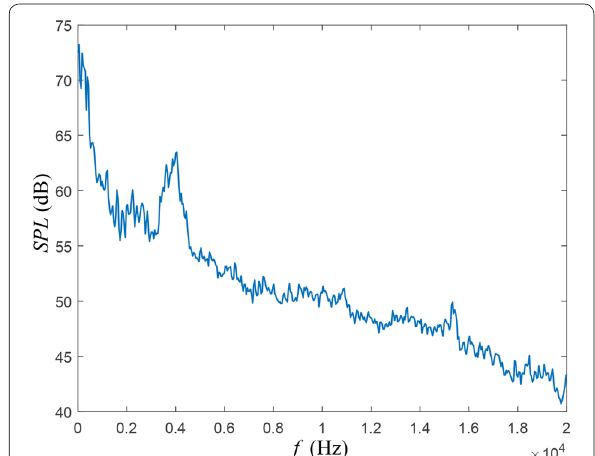
Figure 12 Power spectrum of the gas leakage experiment